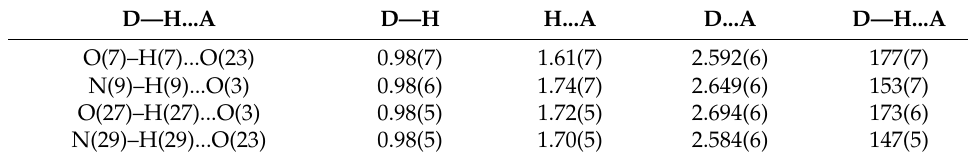
Figure 2. Schematic representation of the hydrogen bonding pattern for 20. Table 1. Hydrogen bonding parameters for 20 (Å, °).